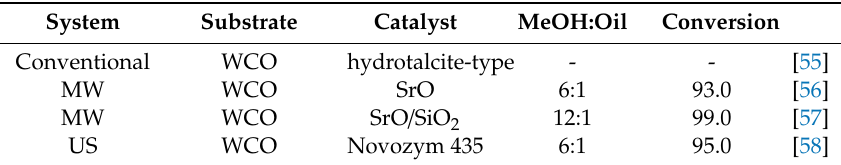
Table 5. Flow processes for biodiesel